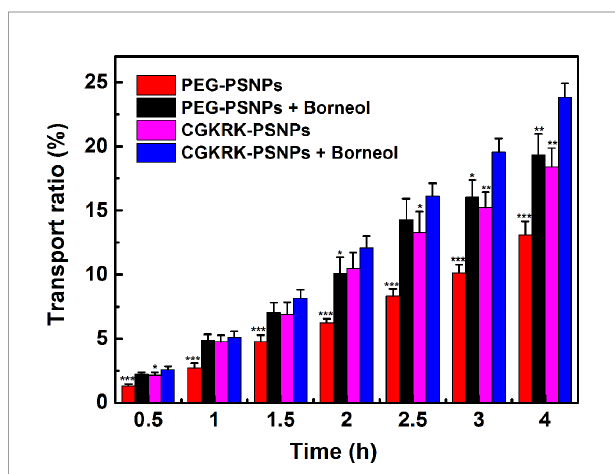
FIGURE 7 | The transport ratios of PEG-PSNPs and CGKRK-PSNPs (with or without borneol) across the BBB model in vitro . *** P < 0.001, ** P < 0.01, * P < 0.05 signi fi cantly lower than that of CGKRK-PSNPs with